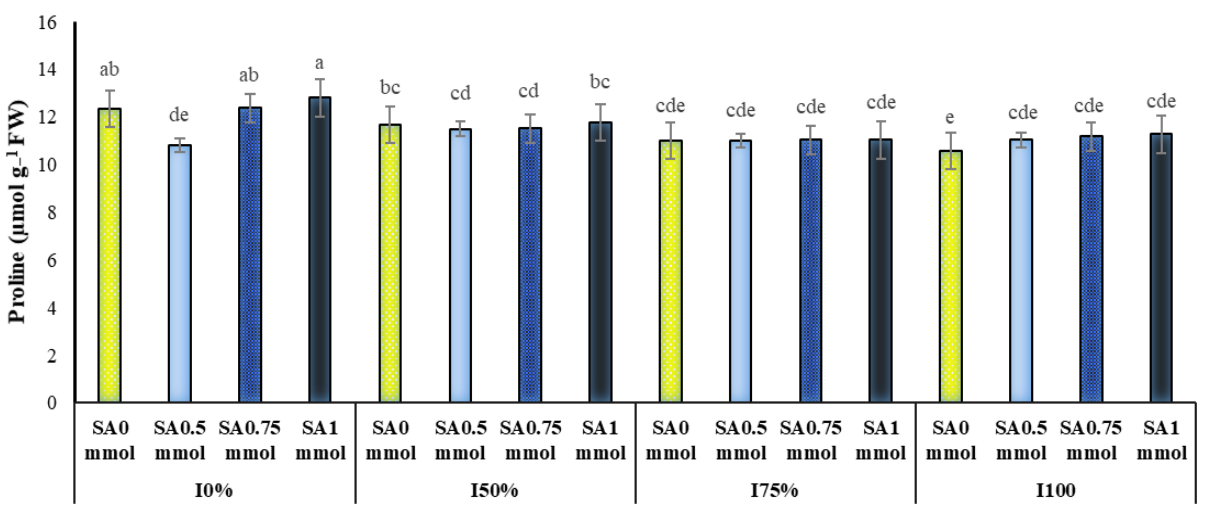
Figure 1. Dual interaction of different levels of irrigation (I0 = no irrigation, I50% = 50%, I75% = 75% and I100% = 100% water requirement of the plant) and salicylic acid application concentrations (SA0 = non-application, SA0.5 = 0.5 mmol, SA0.75 = 0.75 mmol and SA1 = 1 mmol) on the proline content of A. hirtifolium . Columns designated by the same letter are not significantly different at the p ≤ 0.05 level as determined by the LSD test.